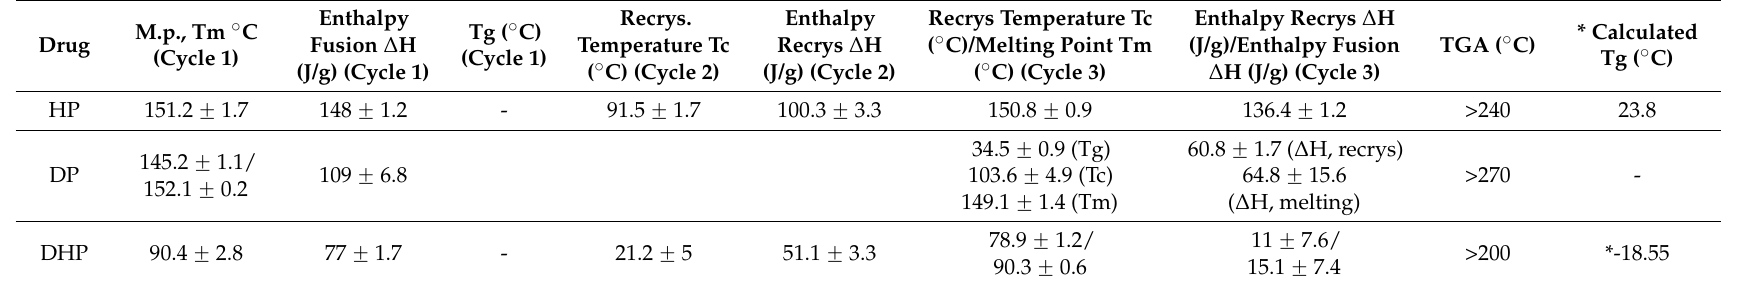
Table 2. Summary of Thermal Events of HP, DP, DHP. Cycle 1 = Heat, Cycle 2 = Cool, Cycle 3 = Reheat. Recrys. = recrystallization, M.p. = melting point.